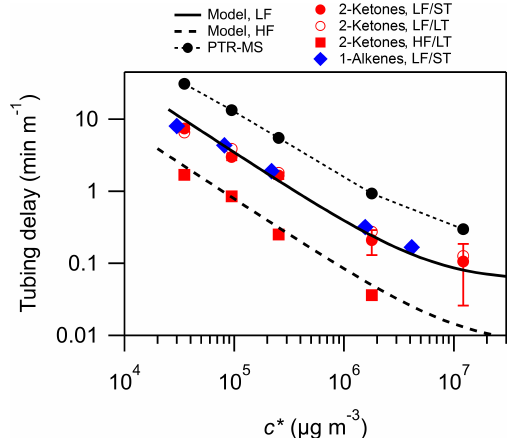
Figure 5. Simulated tubing delays presented as a function of c ∗ and flow rate for 3/16in. ID PFA Teflon tubing. The range of conditions for measurements made in this study are shown by the dashed box. Values of c ∗ were calculated using SIMPOL.1 (Pankow and Asher,